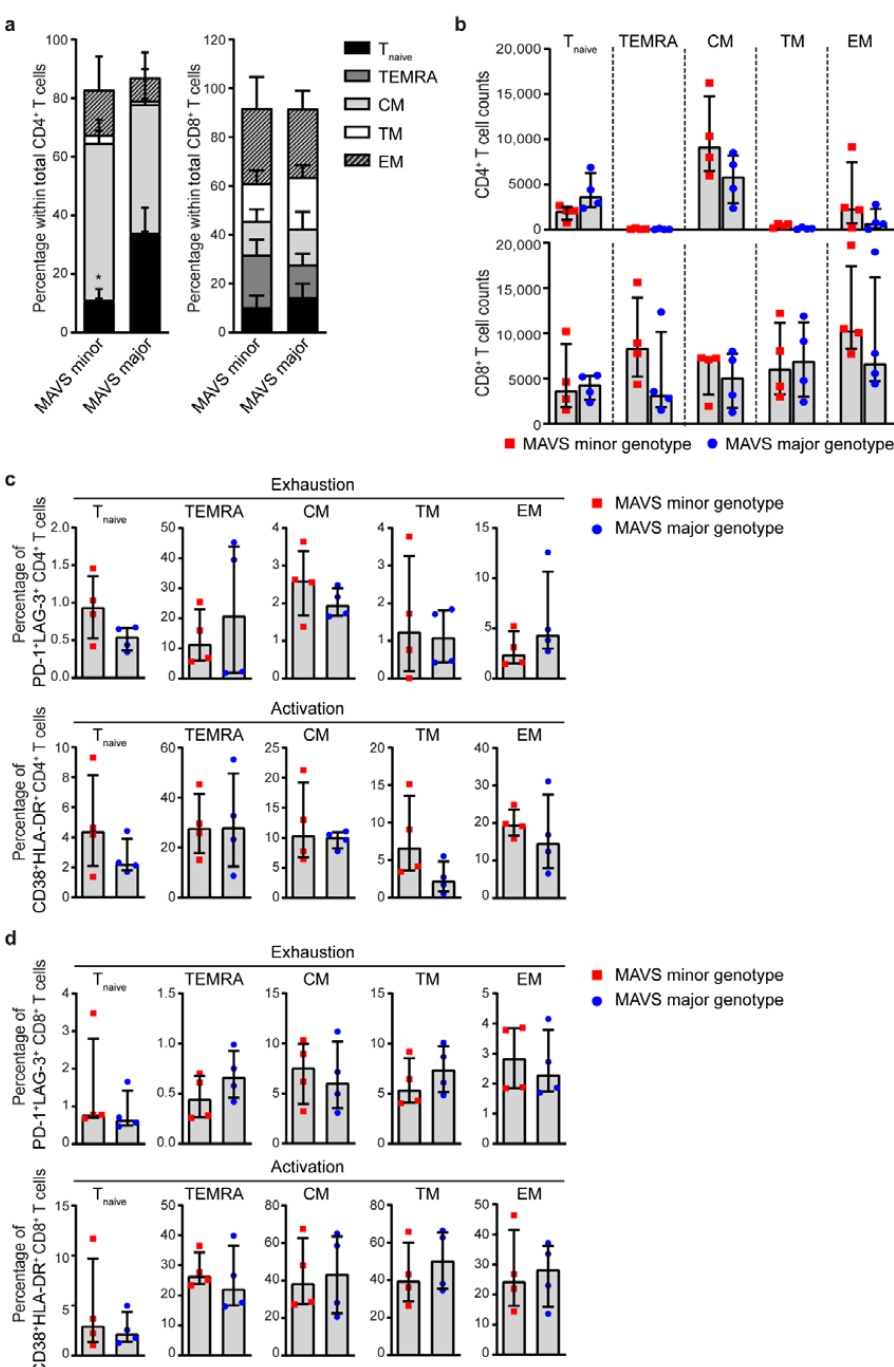
Figure 4. MAVS minor genotype is associated with a decreased percentage of naïve CD4 + T cells. ( a ) Percentages and ( b ) cell counts of naïve (T naive ; CD45RA + CD27 + CCR7 + ), terminally differentiated effector memory (TEMRA; CD45RA + CCR7 − CD27 − ), central memory (CM; CD45RA − CCR7 + CD27 + ), transitional memory (TM; CD45RA − CCR7 − CD27 + ), and effector memory (EM; CD45RA − CCR7 − CD27 − ) cells within CD4 + and CD8 + T cells were analyzed using flow cytometry. ( c ) Percentages of exhausted (PD-1 + LAG-3 + ) and activated (CD38 + HLA-DR + ) CD4 + T cells and ( d ) CD8 + T cells within T naive , TEMRA, CM, TM, and EM populations were analyzed using flow cytometry. Each square or dot represents a di ff erent study participant (median ± IQR). All significant di ff erences are indicated: * p < 0.05, unpaired Mann–Whitney